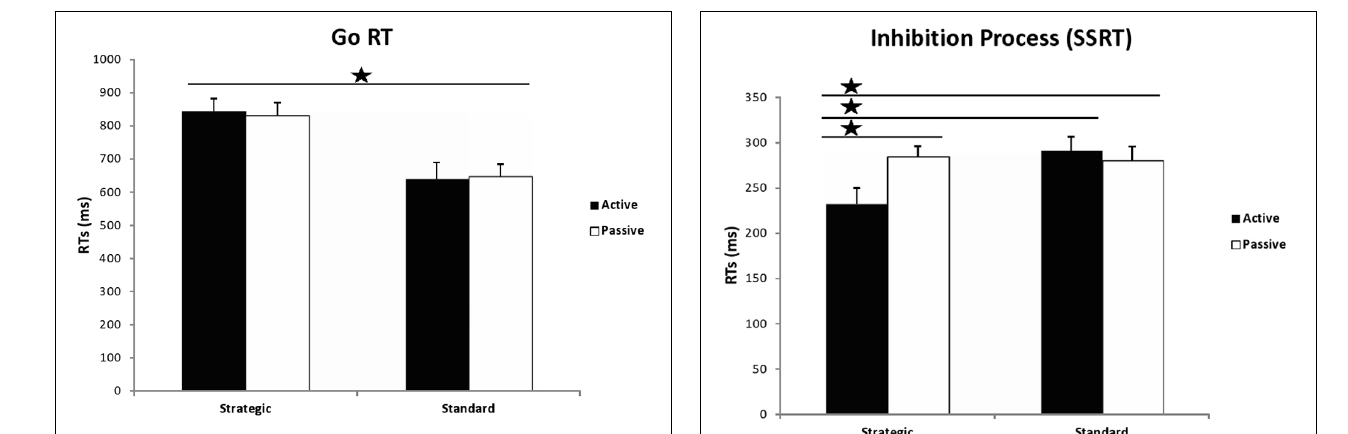
FIGURE 3 | Latency of the inhibition process (SSRTs) in milliseconds, calculated by subtracting the mean SSD from the mean RT in go trials, for active and passive participants in both conditions of the Stop Signal Task: strategic and standard. The stars indicate significant differences between strategic active group and the remaining groups with p < 0 .